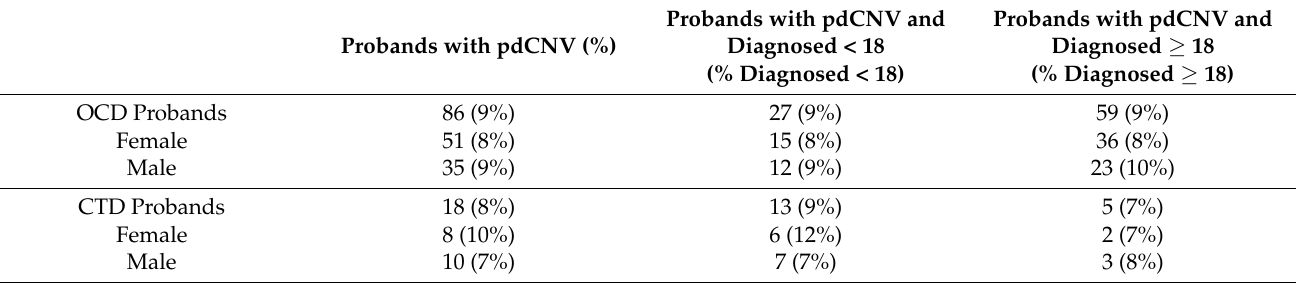
Table 2. Characterization of the OCD and CTD probands with potentially damaging